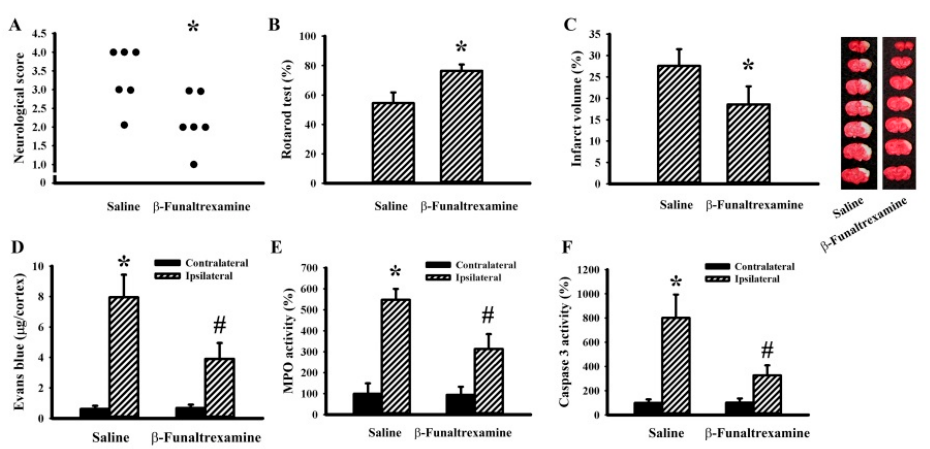
Figure 6. β -funaltrexamine protected against cerebral I/R injury. Rats receiving normal saline vehicle or β -funaltrexamine (82.5 nmol/30 μ L) intracerebroventricular infusion were subjected to both Common Carotid Arteries (CCAs) and the right middle cerebral artery (MCA) occlusion for 90 min followed by 24-h reperfusion. ( A ) Neurological deficits were evaluated by neurological score. ( B ) The motor performance was assessed by a Rotarod test. ( C ) Representative photographs show the histological examination of a brain infarction by Triphenyltetrazolium Chloride (TTC) staining. The average percentage of infarction volume in the ipsilateral hemisphere is depicted. ( D ) The contents of Evans blue in contralateral and ipsilateral cortical tissues were measured by an Evans blue extravasation assay. Proteins were extracted from the contralateral and ipsilateral cortical tissues and subjected to an enzymatic assay of Myeloperoxidase (MPO) activity ( E ) and caspase 3 activity ( F ). * p < 0.05 vs. saline or the contralateral tissues of the vehicle groups and # p < 0.05 vs. the ipsilateral tissues of the vehicle groups, n = 6.